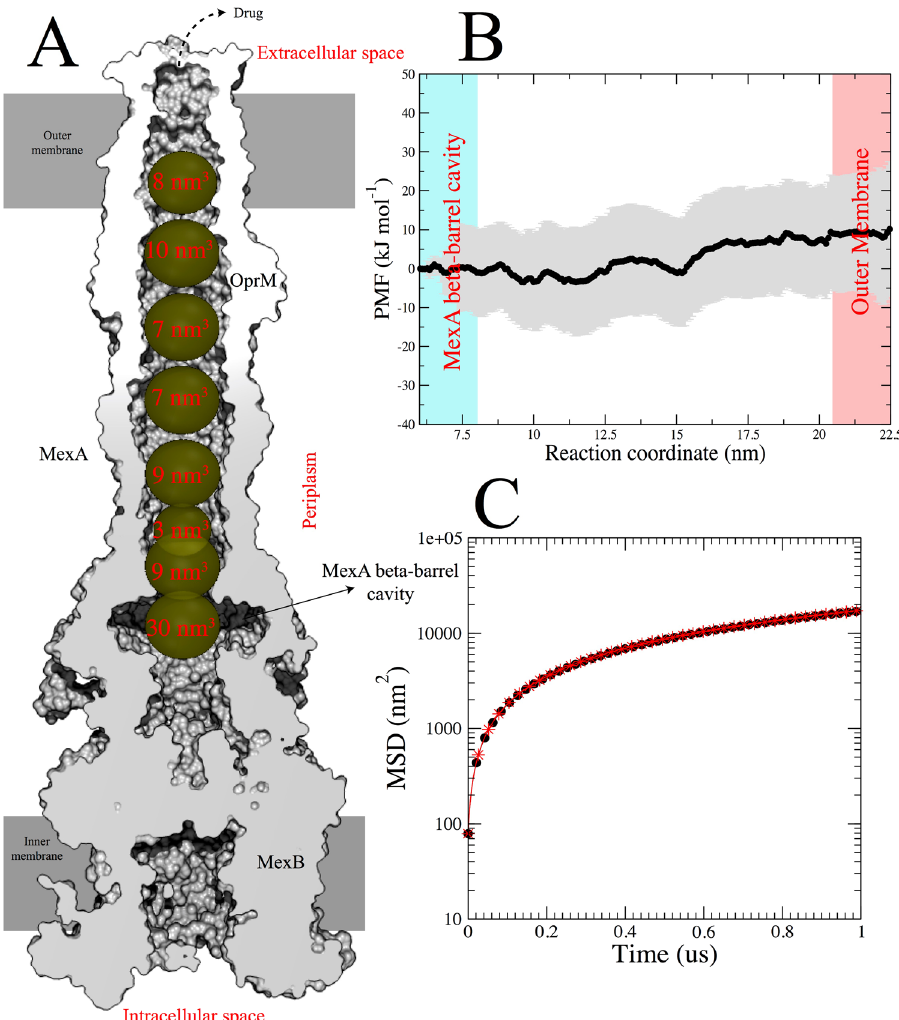
Figure 8. Rifampicin translocation through the conduit of OprM in the MexAB-OprM pump. ( A ) Cross section of the equilibrated fully assembled pump, showing the averaged volume of the conduit along the OprM and MexA complex. ( B ) Potential of mean force for the translocation of rifampicin through the channel formed by the MexA and OprM domains. The total cumulative energy suggests the process is diffusive as values range within thermal fluctuations (~4 kJ mol − 1 ). ( C ) Comparison of the mean square displacement (MSD) for the water molecules running inside the OprM-MexA channel (black circles) and water molecules outside the boundaries of the pump (red stars), suggesting that water diffusion inside the pump is not